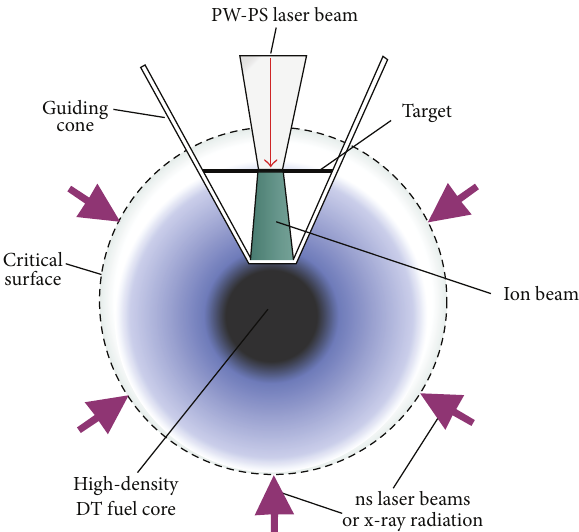
Figure 8: Application of plasma block acceleration for improving the proton-fast-ignition fusion scheme with 1000 times higher ion current densities from the block acceleration.